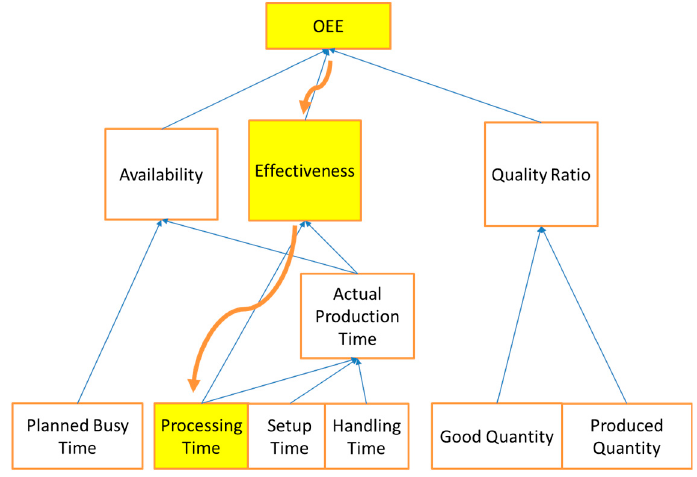
Figure 13. Tracking the cause of the OEE alarm back to Processing Time.